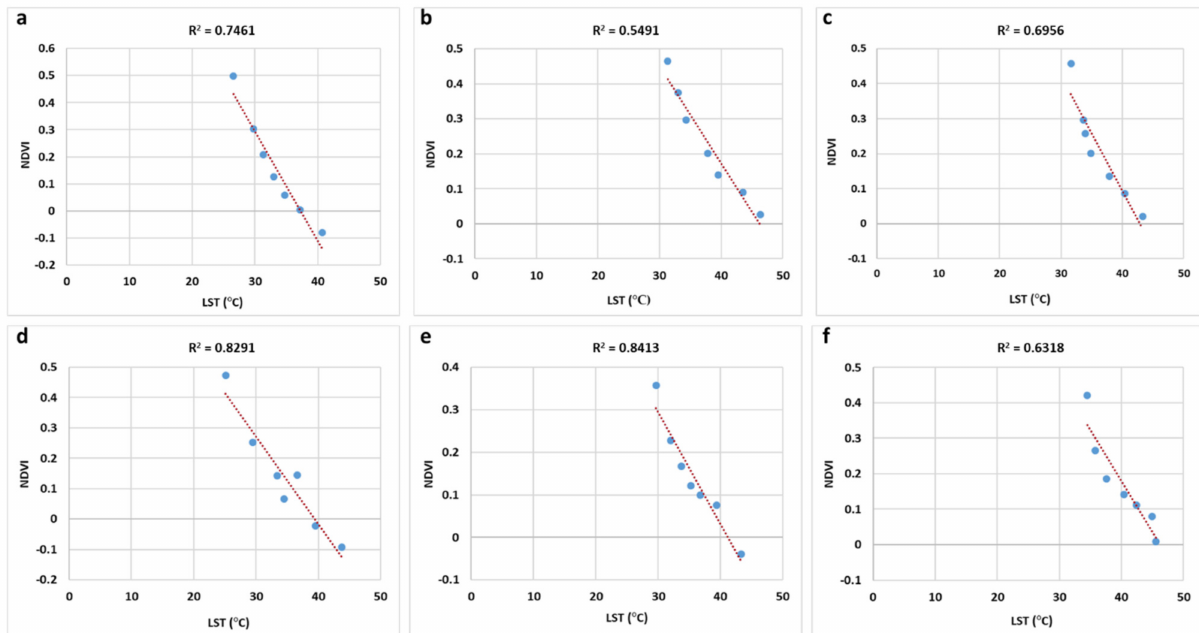
Figure 7. Linear regression analysis between LST and NDVI for Damascus in 2010 ( a ), 2014 ( b ), and 2018 ( c ) and for Aleppo in 2010 ( d ), 2014 ( e ), and 2018 ( f